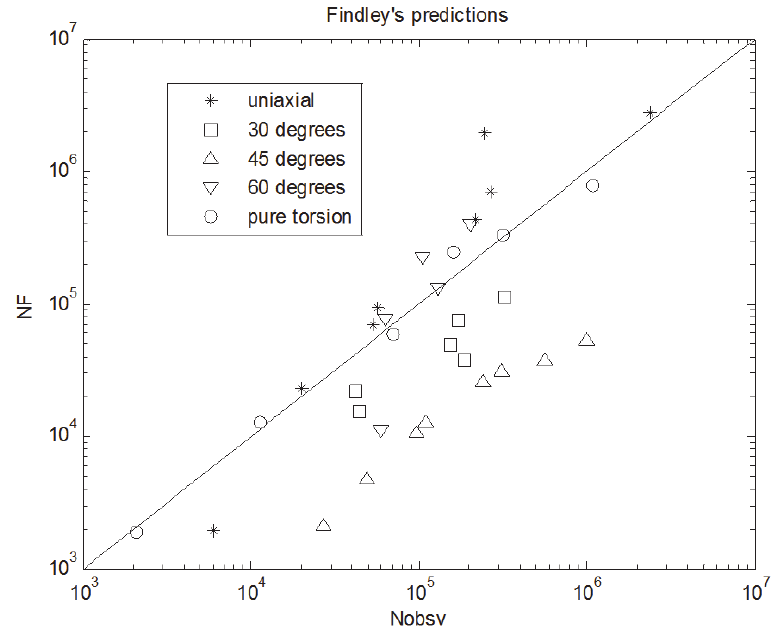
Figure 3: Comparison between the observed fatigue lives N obsv and the predicted N F